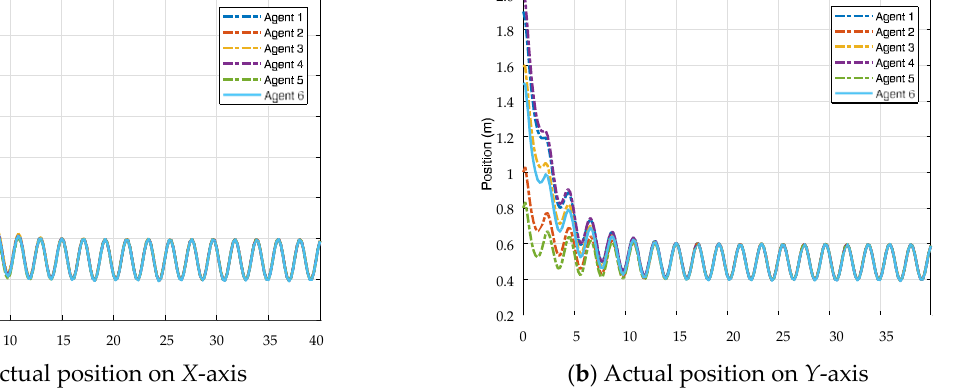
Figure 4. The actual positions of six agents.